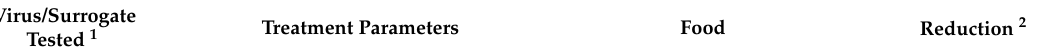
Virus/Surrogate Tested